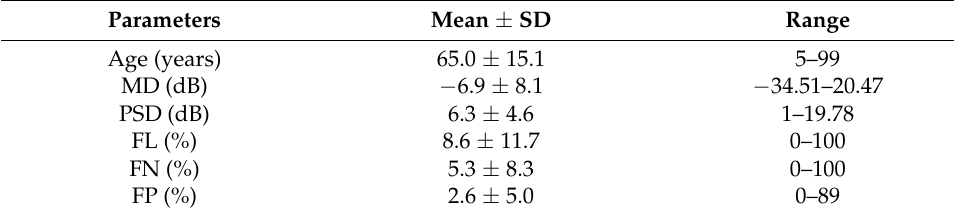
Table 1. Demographic subject